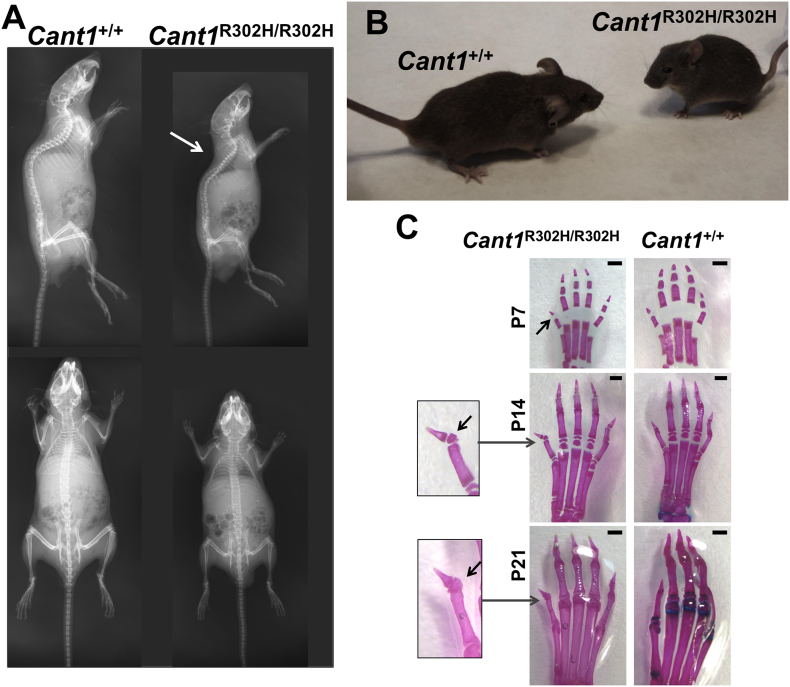
Cant1 knock-in mice show a skeletal phenotype reminiscent of the human DBQD1. (A) X-ray images of two month old Cant1 knock-in (Cant1R302H/R302H) mice showed reduced growth compared with wild type (Cant1+/+) animals. Moderate thoracic kyphosis (arrow) was present in Cant1R302H/R302H mouse. (B) Gross morphology of a two month old Cant1R302H/R302H and Cant1+/+ mice showing growth retardation in the mutant littermate. (C) Alcian blue and alizarin red staining of the hind limb extremities at different ages showed the presence of a delta phalanx (arrow) in Cant1R302H/R302H mice. Scale bars = 0.5 mm.